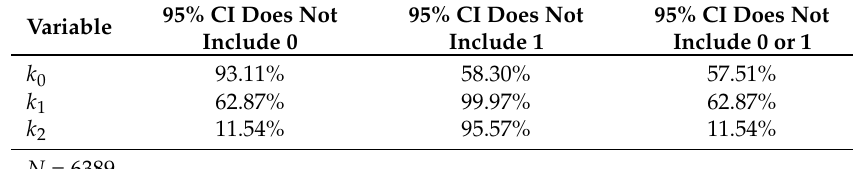
Table 8. Percent of players we reject always or never playing a